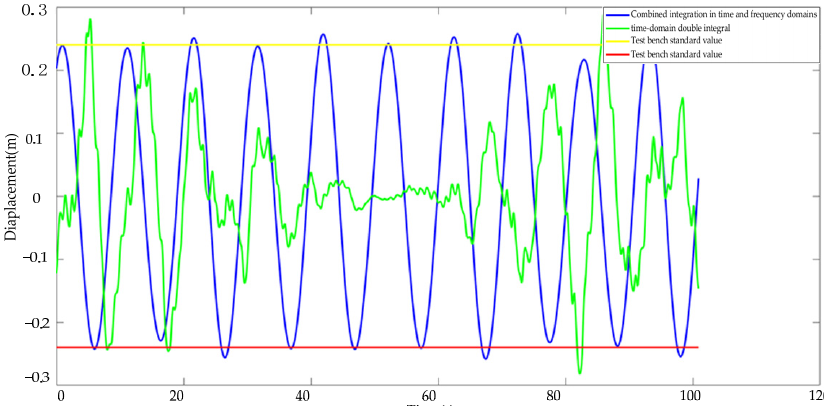
Figure 15. Algorithm curves of different gallop amplitudes.